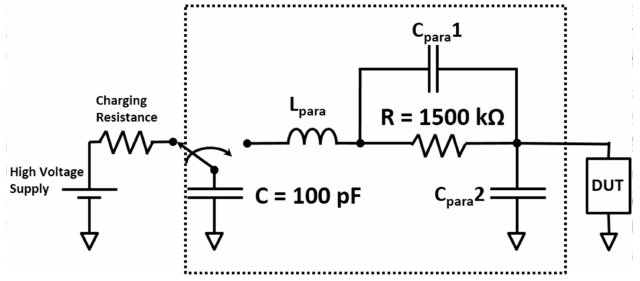
Figure 2. The schematic of the ESD test circuit in HBM configuration for the experimental characterization of the power